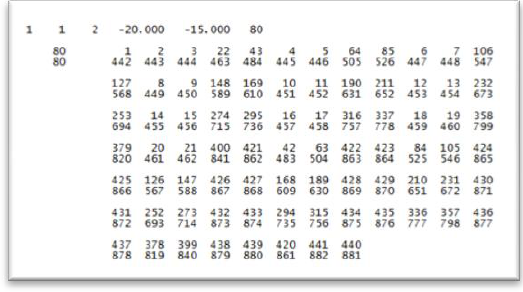
Figure 13. Relational matching for chains